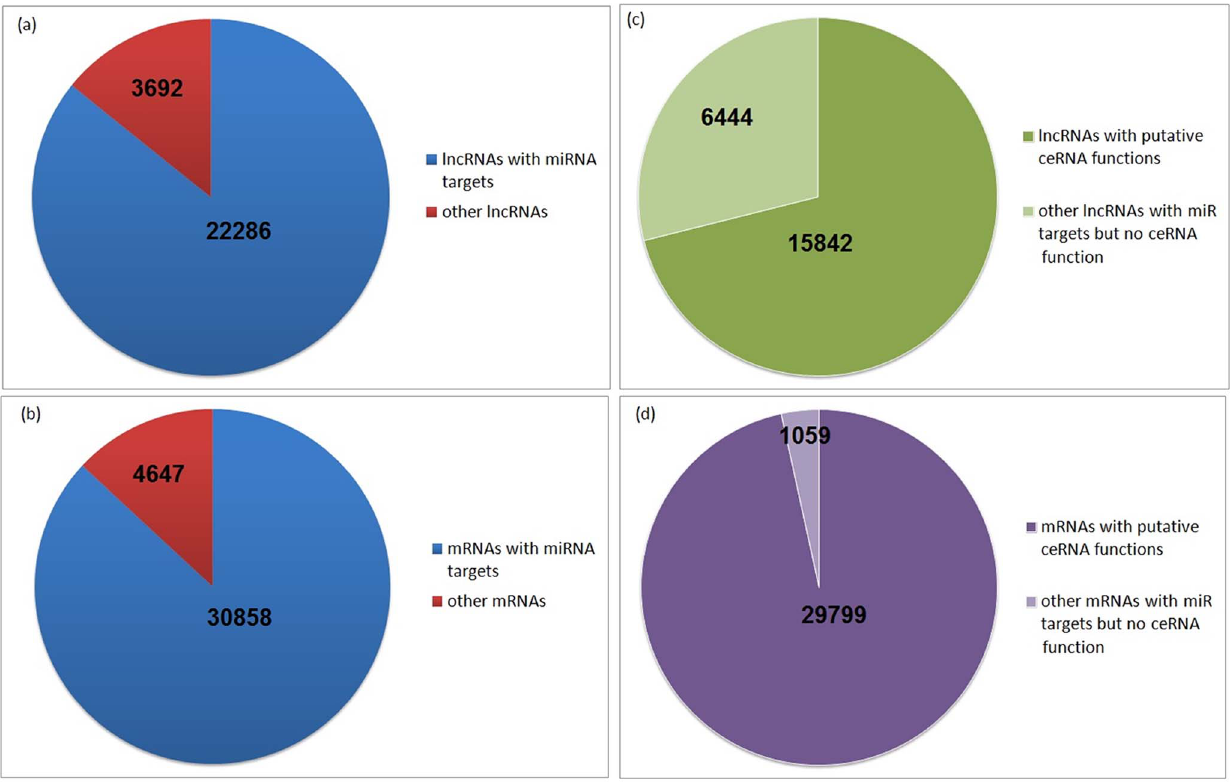
Figure 1. A statistics of the database contents in ln Ce DB. (a) Fraction of GENCODE 19 lncRNA transcripts with putative miRNA targets. (b) Fraction of mRNAs with predicted miRNA targets. (c) Fraction of lncRNAs with predicted ceRNA function compared to all lncRNAs with putative miRNA targets. (d) Fraction of mRNAs with predicted ceRNA function compared to all mRNAs with putative miRNA targets.